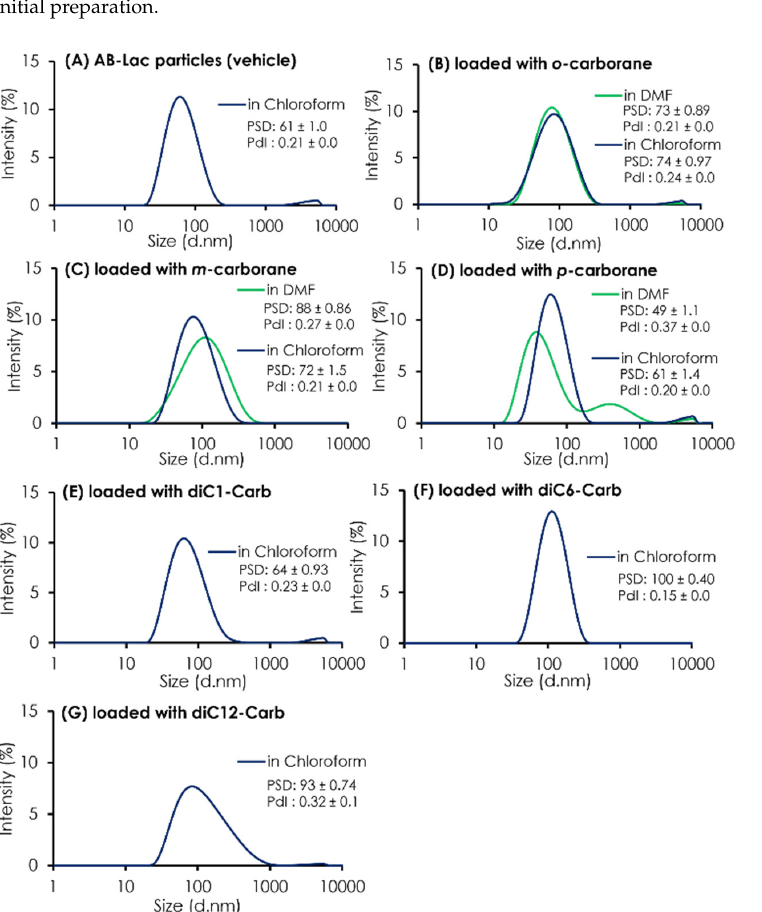
The Ratio (B:AB-Lac Polymer) ( µ mol: µ mol)